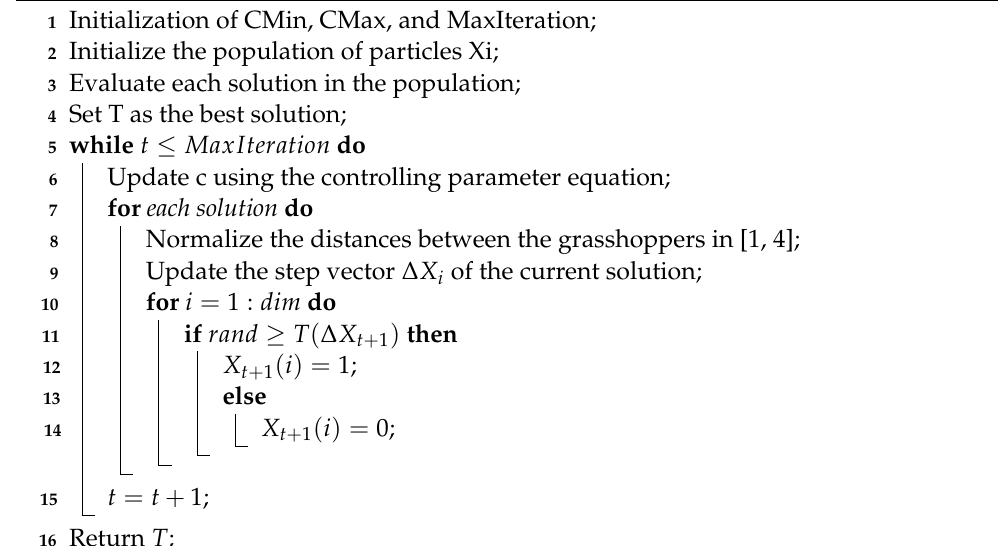
Algorithm 3: Binary grasshopper optimization algorithm (BGOA)